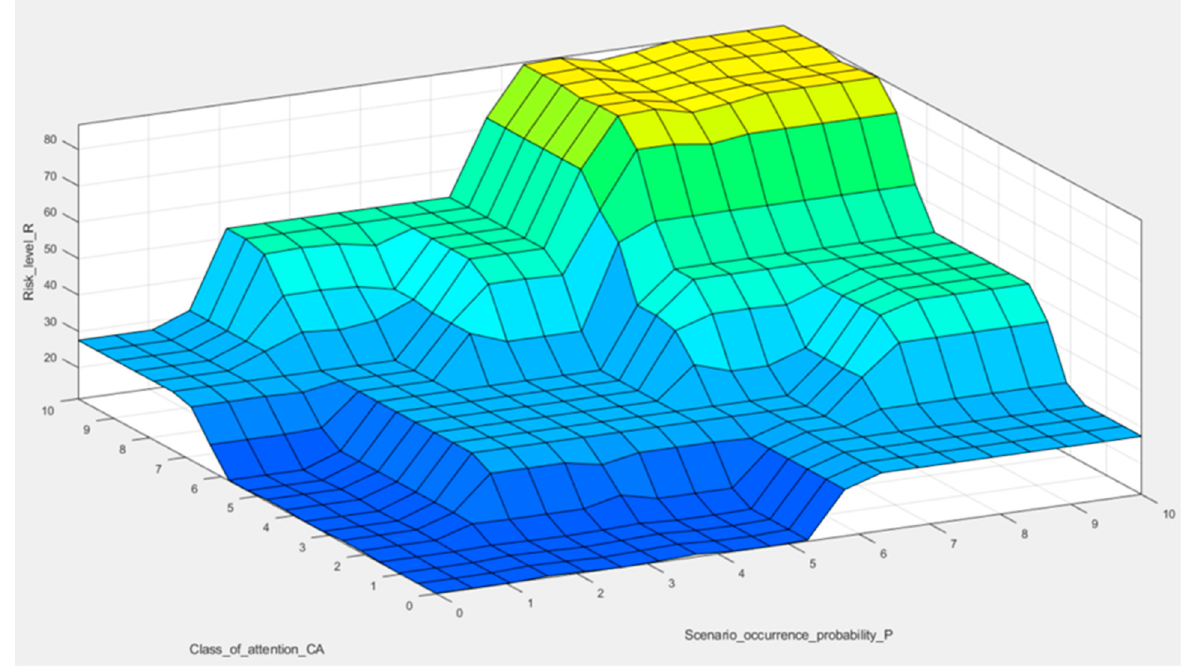
Figure 12. Surface view of the proposed fuzzy inference system for mining machinery (rules with weights equal to 1).